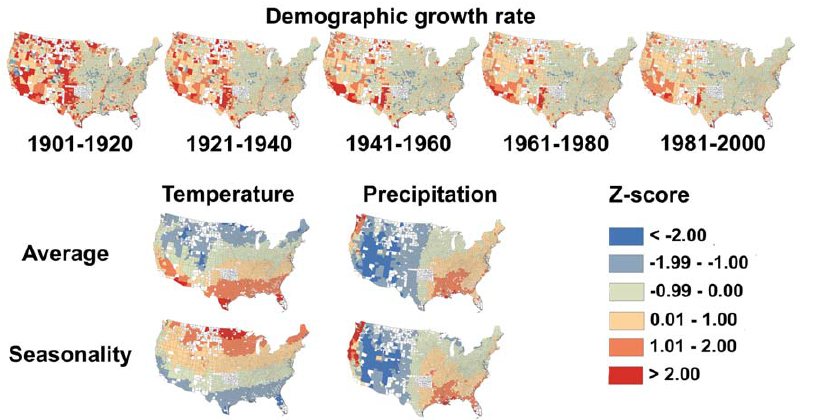
Figure 1. Spatial patterns of demographic growth rate and climate conditions during the 20 th century. Counties shown in white were not included in the analyses because they did not have consistent census data or changed their geographical boundaries in the 20 th century. Temporal changes are shown based on five 20-year intervals for demographic growth rate whereas climatic variables are only shown for the 1981– 2000 interval because these variables remained very similar throughout the 20 th century (see fig. S1 for the non-climate variables and Fig. S6 for temporal changes in the spatial patterns of climate conditions). In order to directly compare the spatial patterns between variables, each panel represents county z-scores based on the average and standard deviation of that variable throughout the century. A z-score of 0 represent the mean, whereas a value of 1 represent one standard deviation above the mean.